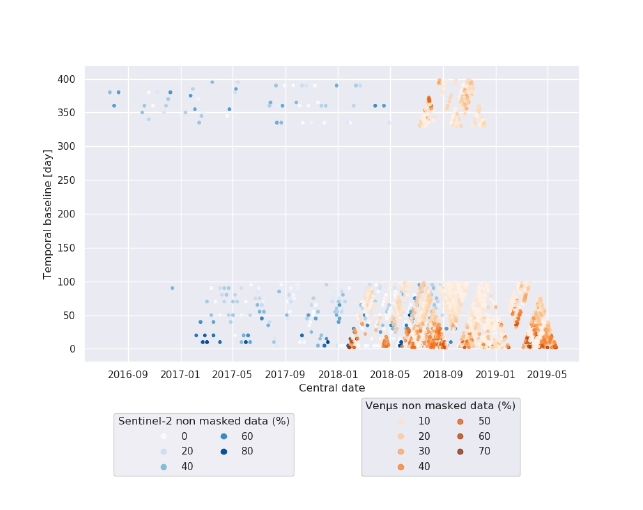
Figure 2. Temporal baselines of the velocity observations according to their central date for Sentinel-2 velocities in blue and Venµs velocities in orange. The colormap which ranges from light to dark blue or orange indicates the percentage of non masked data for each temporal baseline and central